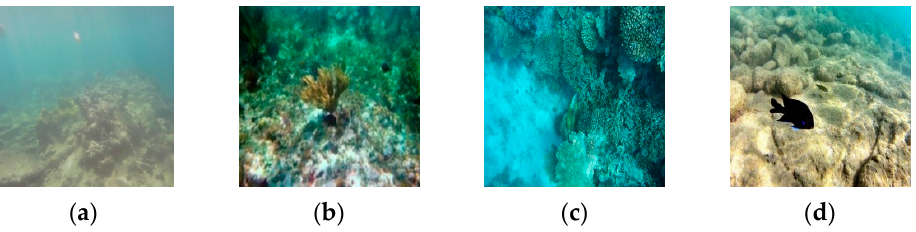
Figure 1. Examples of the underwater synthetic dataset EUVP [7]. ( a , b ): distorted image. ( c , d ): clean image.